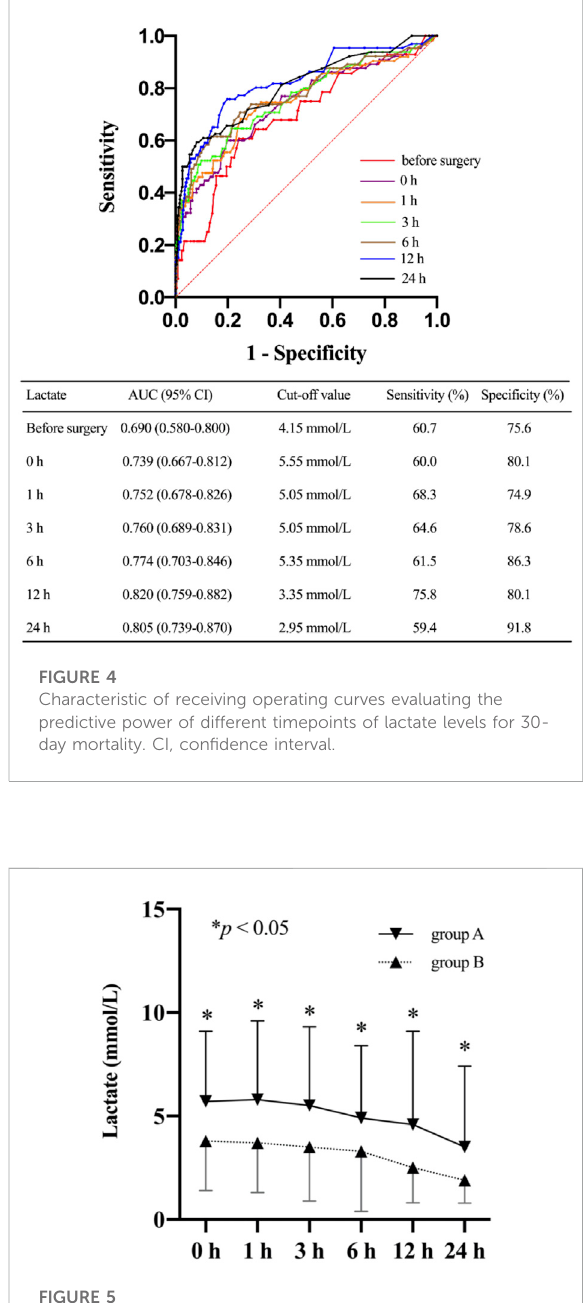
FIGURE 5 Comparison of lactate levels (mean and standard deviation) of patients strati fi ed based on their preoperative lactate